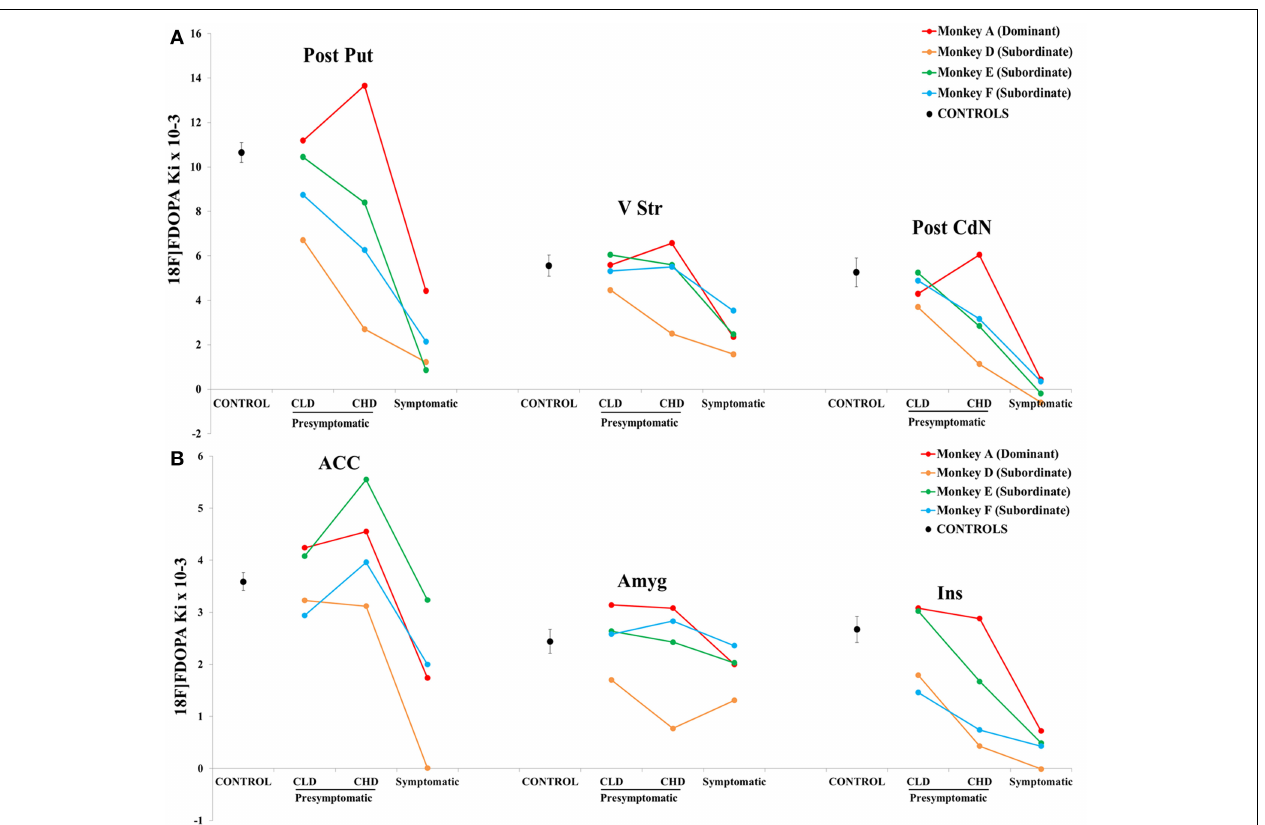
FIGURE 8 | Individual evolution of 18 F-DOPA uptake in (A) 3 striatal (posterior caudate nucleus, posterior putamen and ventral striatum) and (B) 3 cortical (insula, amygdala and anterior cingulate cortex) areas ( n = 4). The 18 F-DOPA uptake value in the different motor states